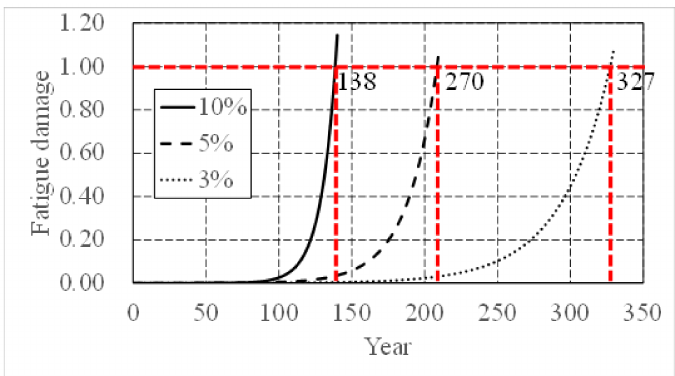
Figure 9. Fatigue-damage accumulation under three growth rates of traffic flow.